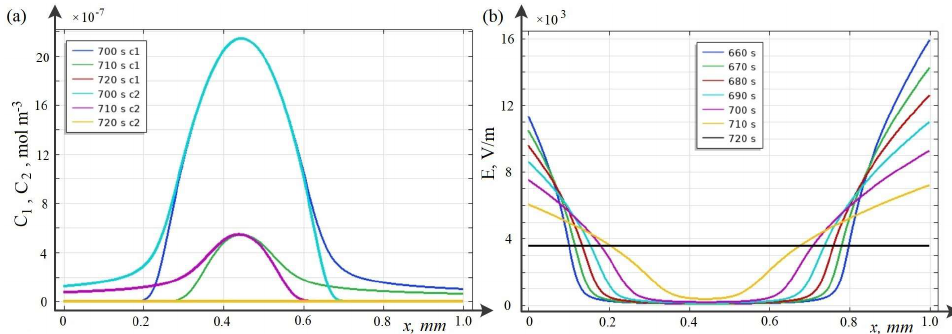
Figure 5. Graphs of concentrations ( a ) and intensity ( b ) at different points in